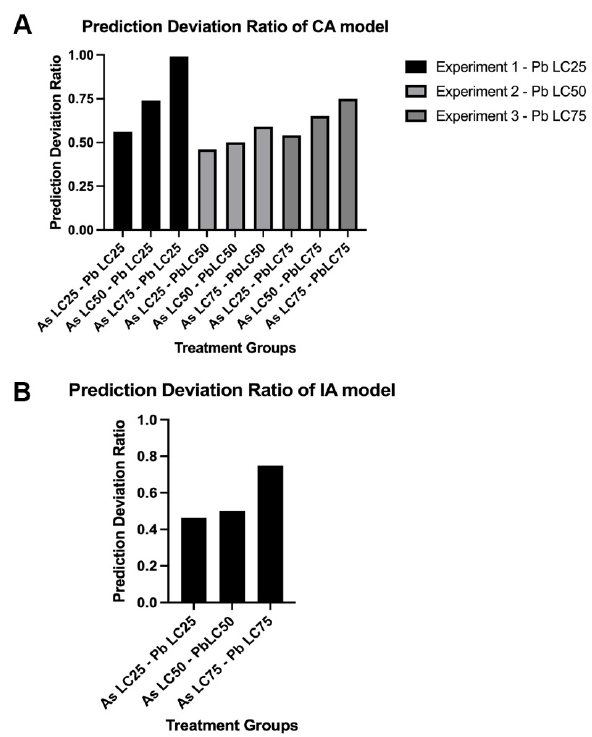
Figure 4. Comparison of prediction deviation ratio (PDR) of mixtures for the CA and IA models. For the CA model ( A ), each exposure scenario in each experiment was evaluated for PDR values that approached 1. The IA model ( B ) is limited to evaluating metal mixtures at the same LC percentage for approaching 1. N = 3 biological replicates for each treatment group with 50 subsamples per each treatment group.